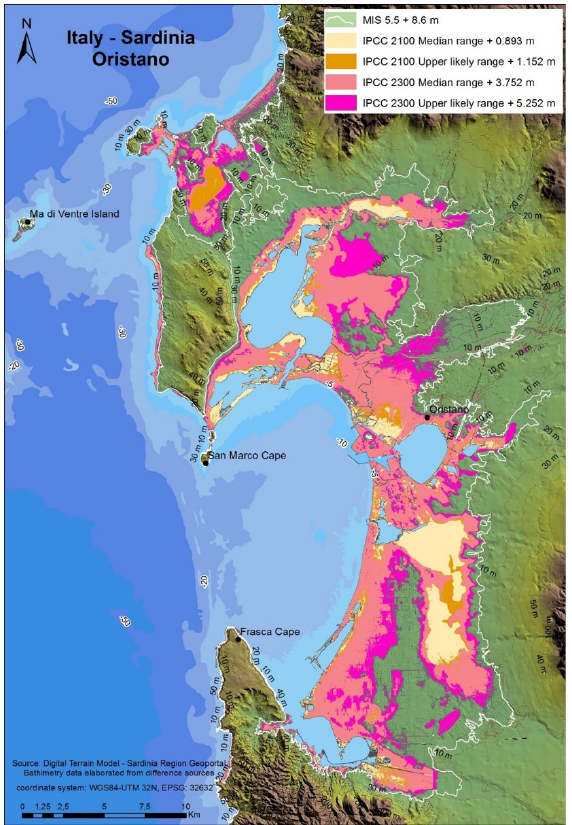
Figure 19. Map of Oristano plane, (see also Figure 2 for location). The potential submersion area, using IPCC AR5 RCP 8.5 projections at 2100 and 2300.